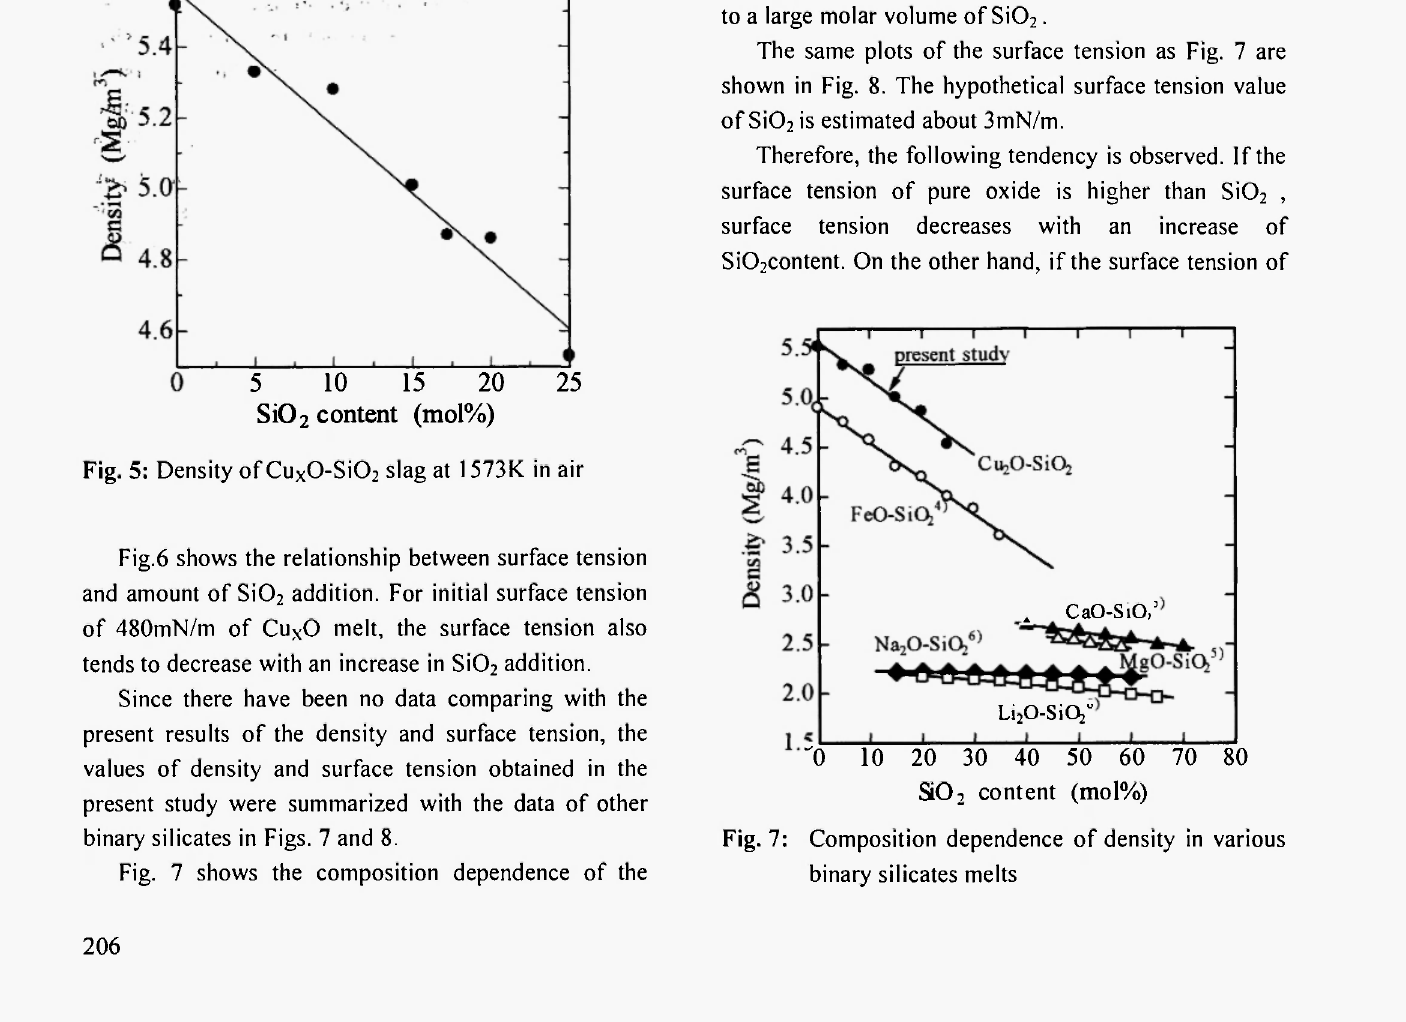
density of binary silicates melts. Although the plotted data in Fig. 7 were measured at different temperatures using various techniques, densities of binary silicate melts tend to decrease with increasing Si0 2 content due to a large molar volume of Si0 2 . The same plots of the surface tension as Fig. 7 are shown in Fig. 8. The hypothetical surface tension value of Si0 2 is estimated about 3mN/m.